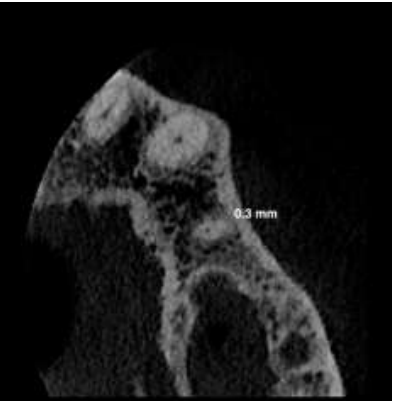
Figure 1. Representative image of a buccal root of first maxillary premolar showing the measure- ment of the diameter in a mesio-distal section. The diameter was 0.3 mm at 1 mm away from the radiographic apex.